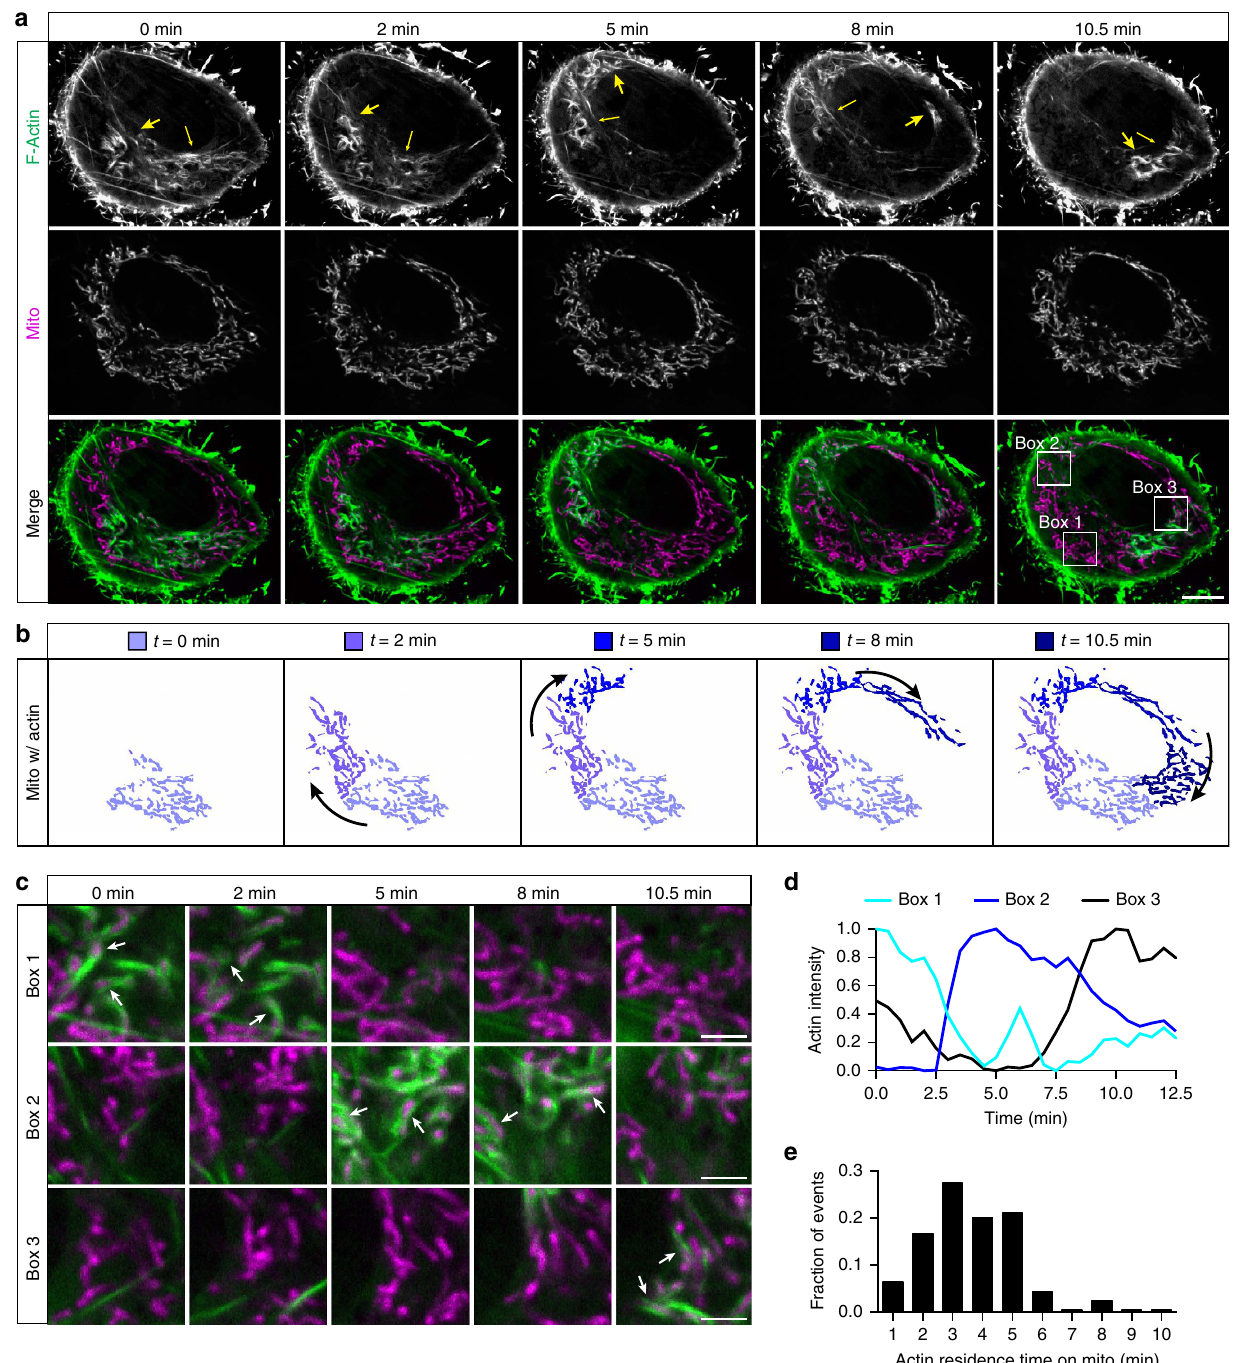
Figure 2 | Actin cycles through mitochondrial subpopulations within the cell. ( a ) Confocal time series showing F-actin (LifeAct-GFP) cycling through different mitochondrial subpopulations within the cell in a clockwise direction over 10.5min. Large arrow indicates leading edge of actin-positive mitochondria; small arrow indicates trailing edge of actin-positive mitochondria. ( b ) Model of actin cycling through mitochondrial subpopulations over time corresponding to ( a ). ( c ) Enlarged images of boxes 1–3, showing temporally ordered actin polymerization/depolymerization on individual mitochondria (white arrows). ( d ) Normalized actin intensities within boxes 1–3 over time. ( e ) Histogram of F-actin residence time on individual mitochondria during cycling. Values represent means ± s.e.m. Scale bars, 10 m m ( a ); 2.5 m m ( c ). Sample size: ( e ) n ¼ 204 mitochondria from 22 cells; n Z 3 independent